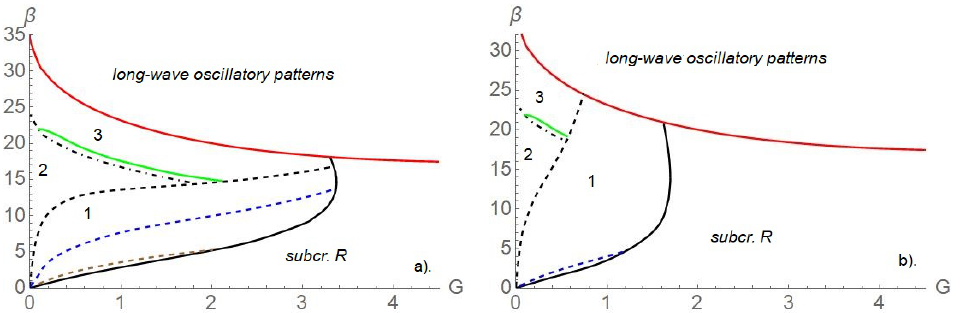
Figure 9. Stability maps for N = 10 − 8 ( a ) and N = 10 − 7 ( b ). Other parameters are L = 0.003 and S = 1. Regions “1”, “2”, and “3” are the same as Figure 3. Dashed and solid lines: blue color for χ 2 = 2, brown color for χ 2 = 5, green color for χ 2 =